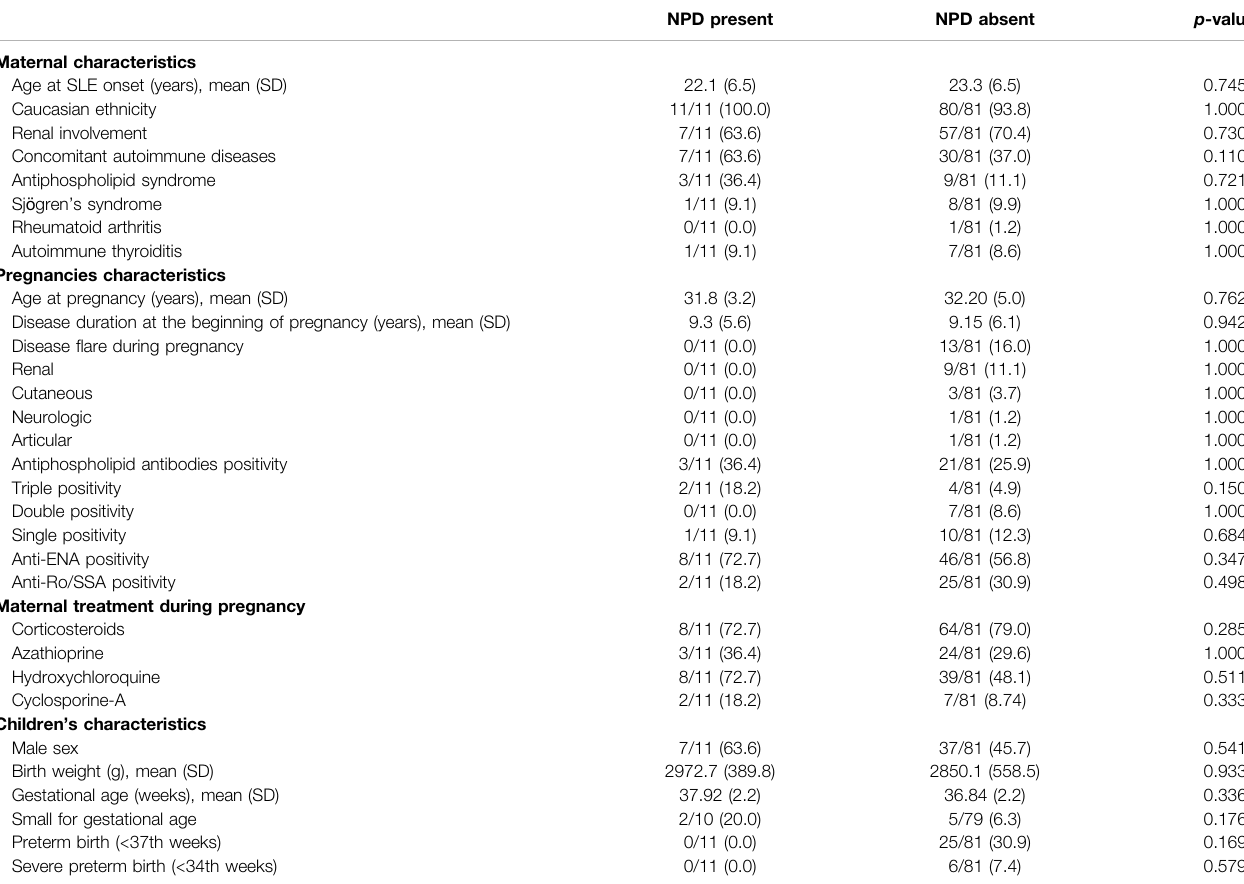
NPD present NPD absent